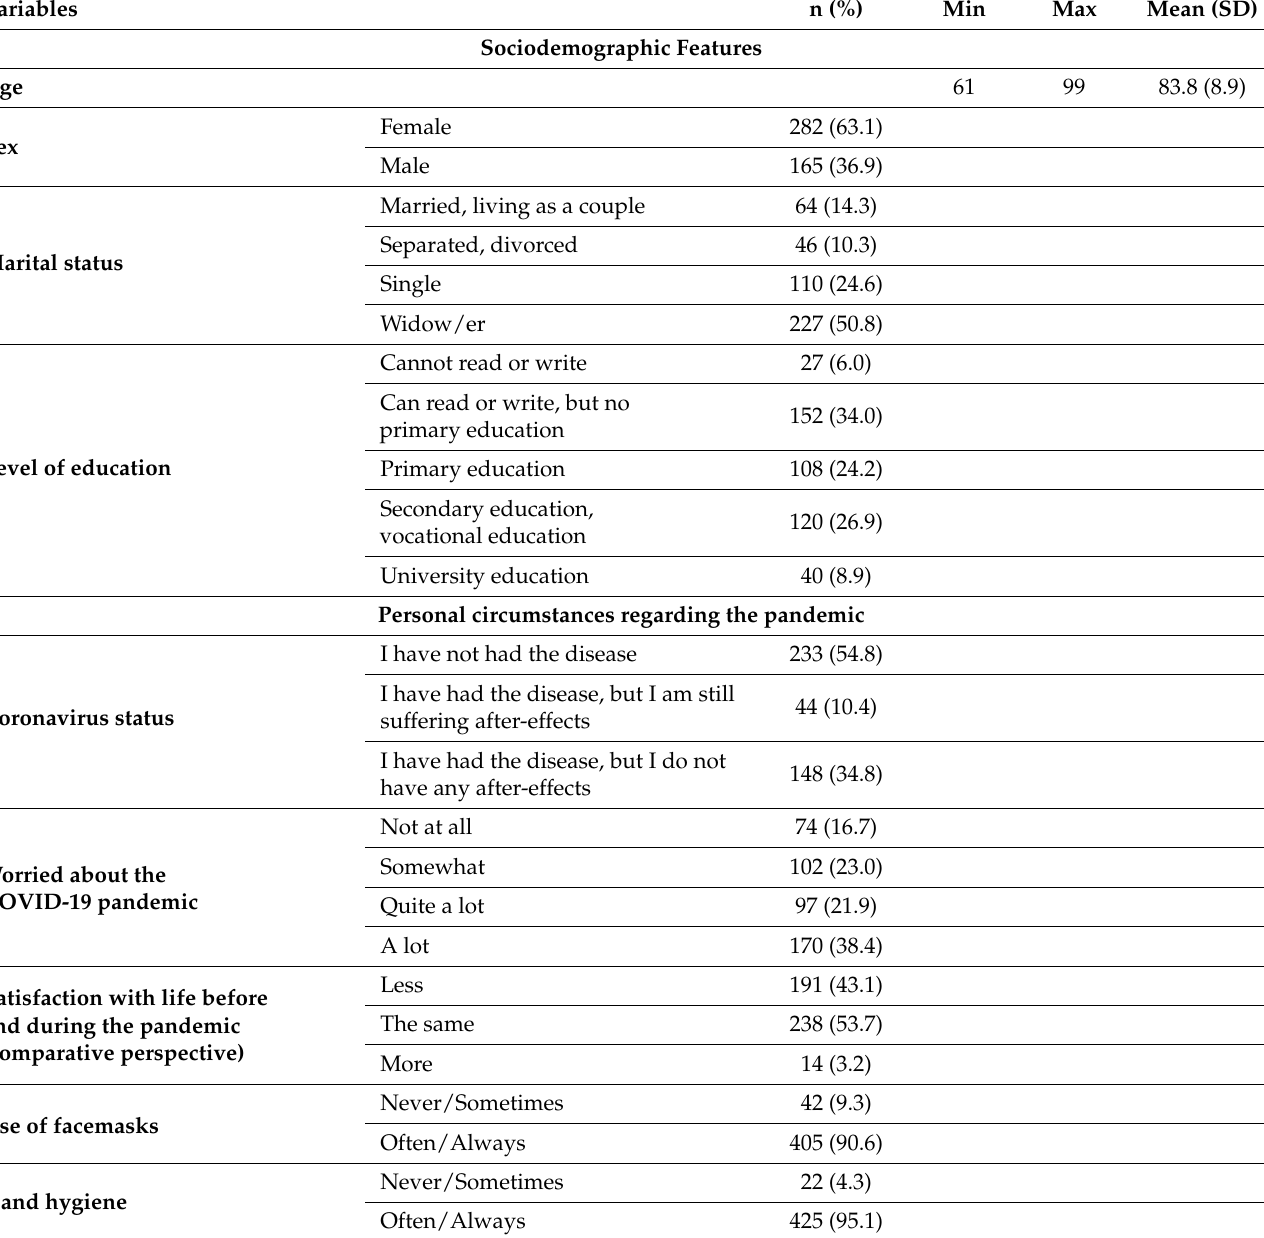
Table 1. Sample characteristics (n =